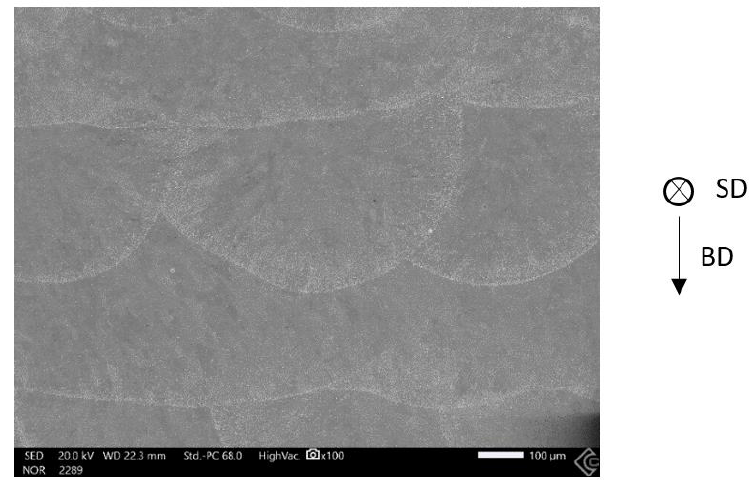
Figure 4. Melt pool morphology for sample T 11 and definition of building direction (BD) and scanning direction (SD).